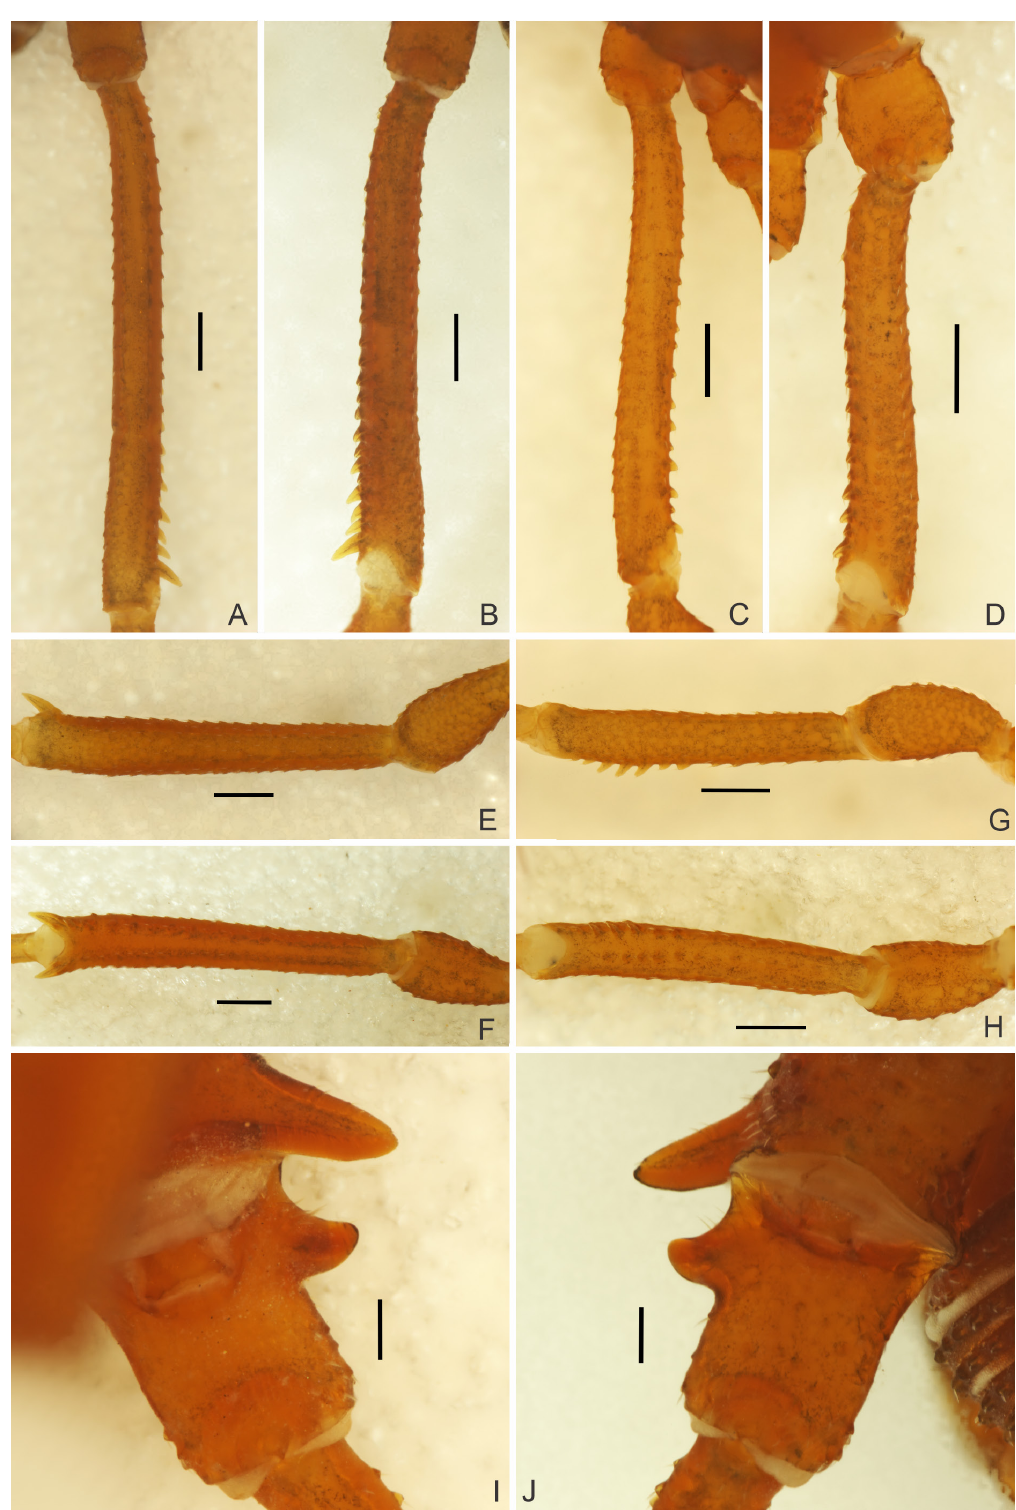
Fig. 8. Eusarcus xambioa sp. nov., ♂, holotype (ISLA 60386). A – B . Femur IV, dorsal and ventral view, respectively. C – D . Femur III, dorsal and ventral view, respectively. E – F . Patella and tibia IV, dorsal and ventral view, respectively. G – H . Patella and tibia III, dorsal and ventral view, respectively. I – J . Detail of trochanter IV, dorsal and ventral view, respectively. Scale bars: A–H = 0.5 mm; I–J = 0.2